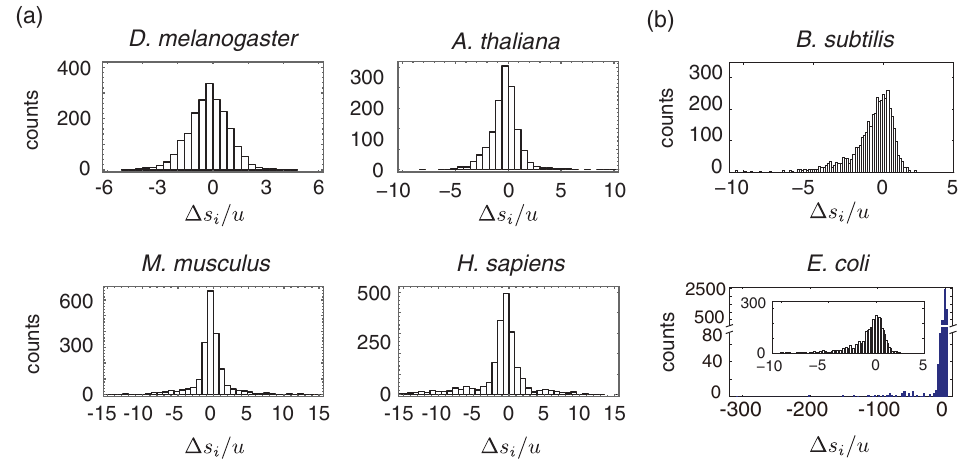
FIG. 5. Distribution of global selective coefficients in different genomes. (a) Selective coefficients of 6-mers in four eukaryotic species. Intron data are used and Δ s i values are given with respect to the 2-mer null model. (b) Selective coefficients of 6-mers measured in two bacterial species. Exon data are used and Δ s i values are given with respect to the synonymous codon-shuffling null model. In E. coli (bottom panels), an inset shows the bulk of the distribution, since a small number of words including known restriction sites have large negative coefficients. Pressure distributions are shown using a value of c ¼ 1 in Eq. (4), which corresponds to taking the average global fitness of a sequence to be